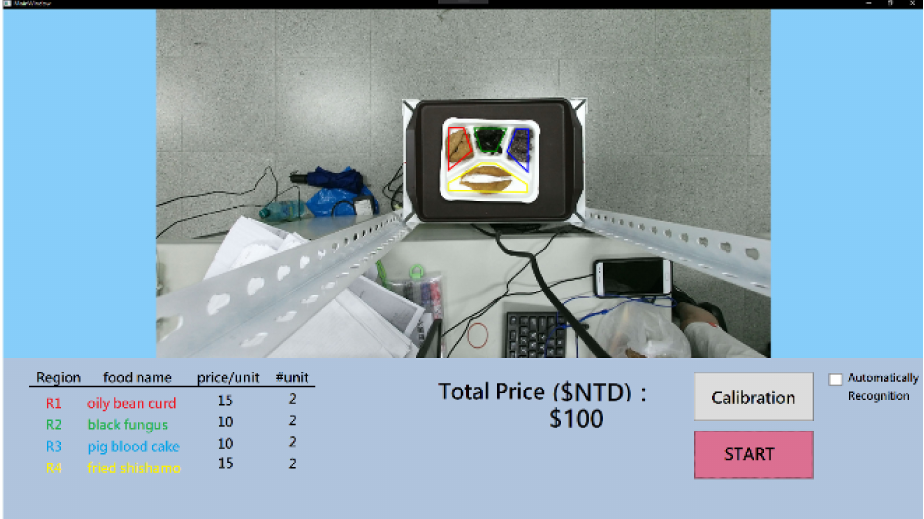
Figure 21. An example using the proposed visual checkout system to estimate food